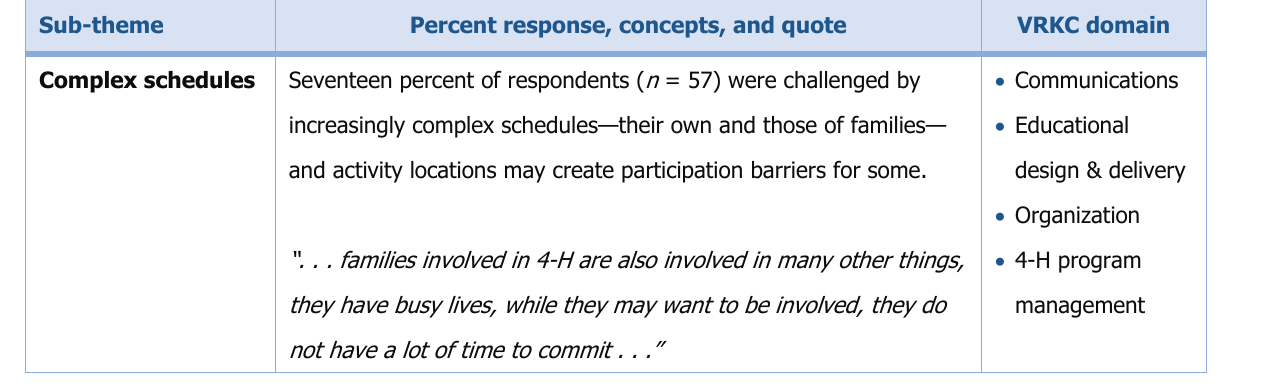
Table 10. “Challenges” Sub -Themes of the Youth and Family Engagement